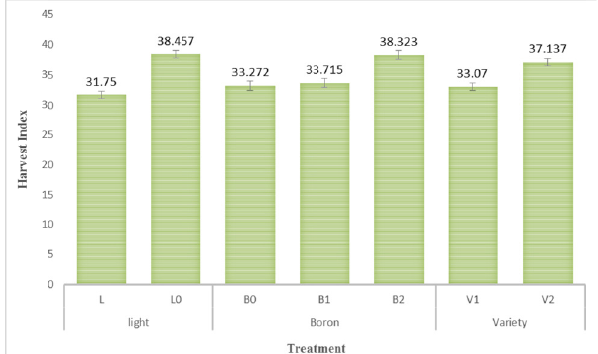
Fig. 1. Effect of boron and light on seed yield (t ha groundnut varieties B= Boron; L=Light; V= Variety; B 0 = 0 kg B ha L= normal day light + 6-h extended red light at day light (≈12-h light), V = ‘BARI Chinabadam-8’. Means were separated by Tukey's test at P ≤ 0.05. Vertical bars represent the standard error of the means.